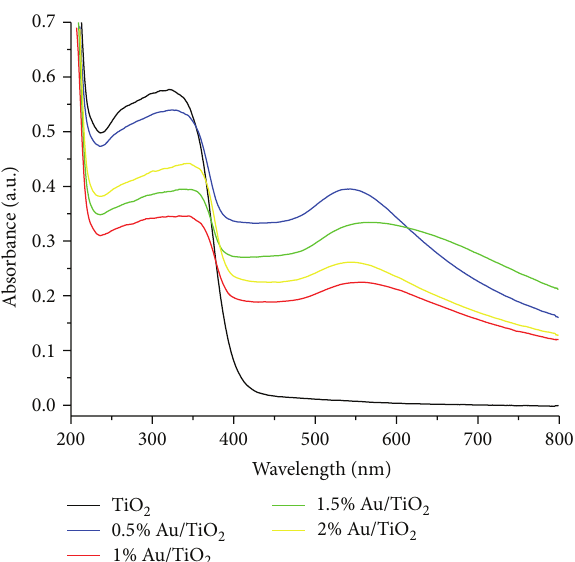
Figure 4: UV-visible diffuse reflectance spectra of Au doped TiO 2 samples.